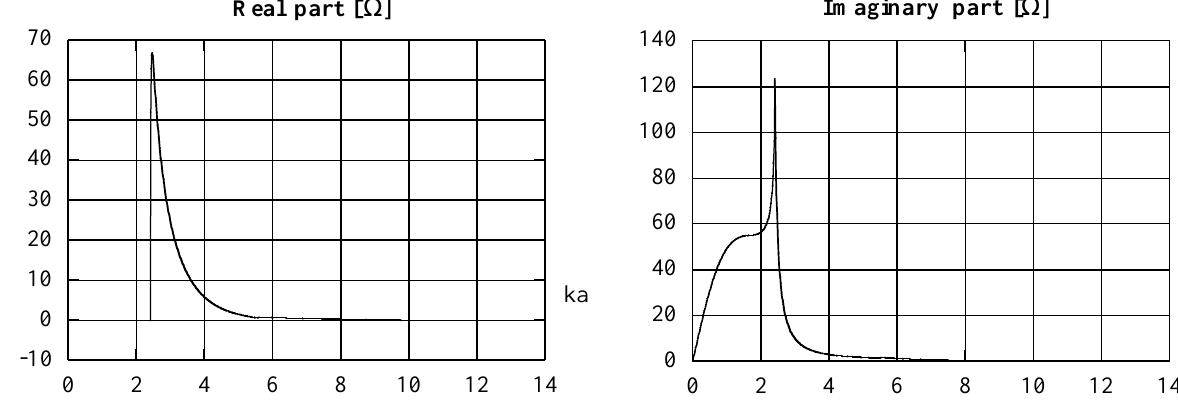
FIG. 10. Real and imaginary parts of the longitudinal coupling impedance in the case (cid:119) (cid:173) (cid:50) (cid:121) (cid:53) and bg (cid:173) (cid:49) .